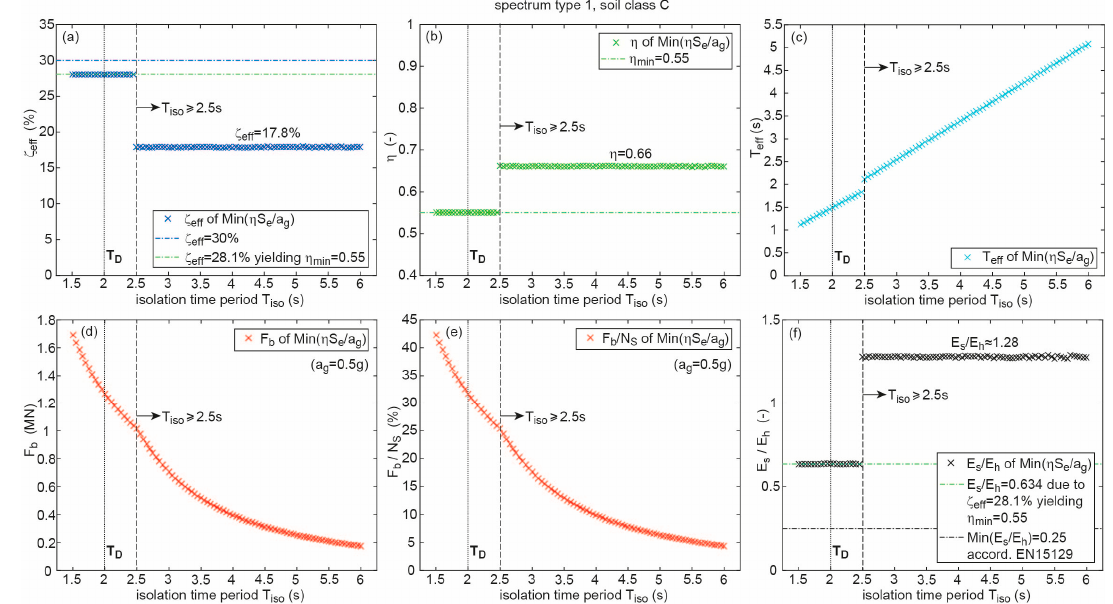
Figure 9. States of optimum solution: ( a ) effective damping ratio; ( b ) reduction factor; ( c ) effective time period; ( d , e ) maximum horizontal CSS force; ( f ) re-centring condition for spectrum type 1 with soil class C. N S : vertical load on CSS; η min : minimum reduction factor.